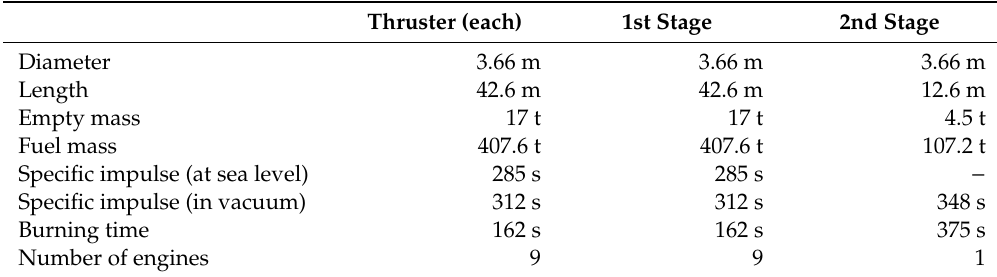
Figure 1. Falcon Heavy rocket. ( a ) The red indicates two lateral thrusters, the first stage blue and the second stage rocket green; ( b ) Coordinate system used to treat the motion in the x – y plane. The blue dashed line shows the approximate flight path. Table 1. Specifications for Falcon Heavy Rocket [12]. The fuel mass data is for the single-use version. The reusable version saves 2–3 tons of fuel in each thruster and the first stage that is required to land that portion of the rocket back to Earth. The specific impulse is proportional to the thrust force